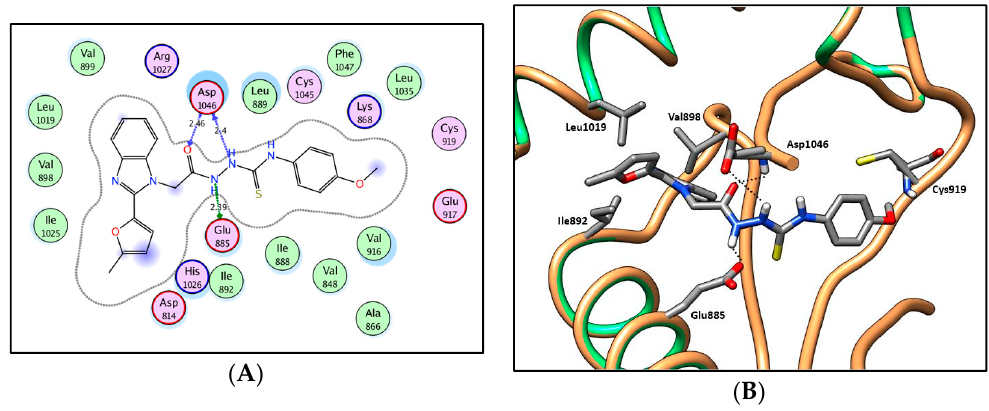
Figure 13. 2D diagram ( A ) and 3D representation ( B ) of compound 24c showing its interaction with the VEGFR-2 active site.